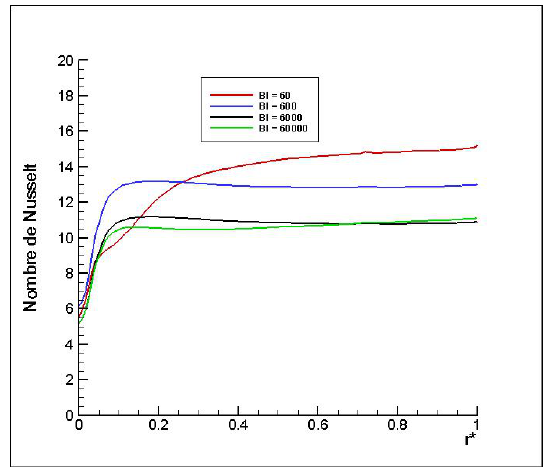
Fig. 9. Inertia effect on the Nusselt number as a function of Reynonlds number.